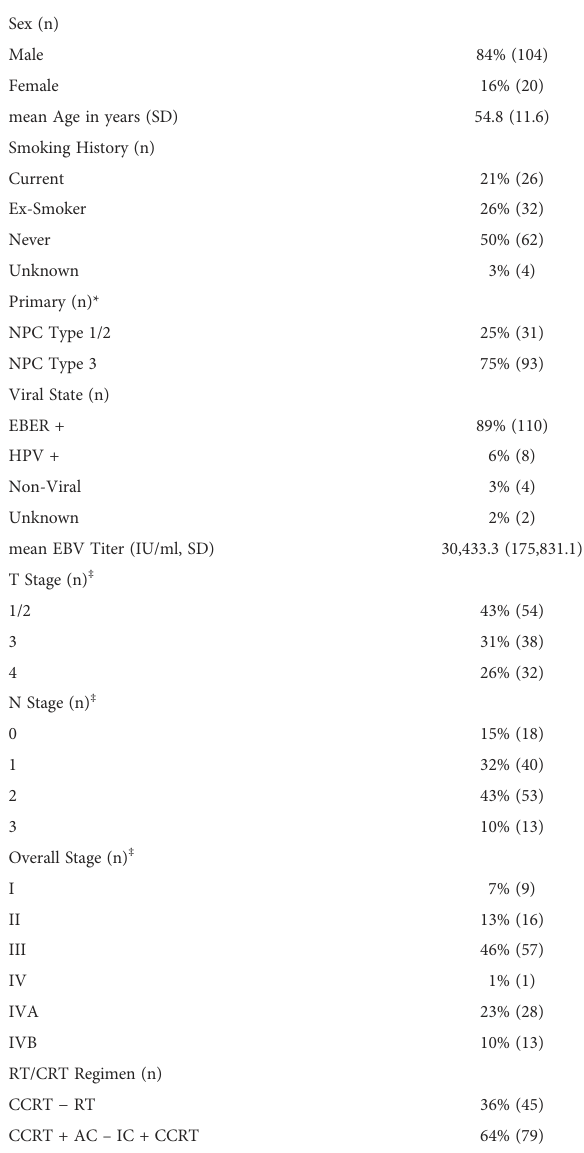
TABLE 1 Population